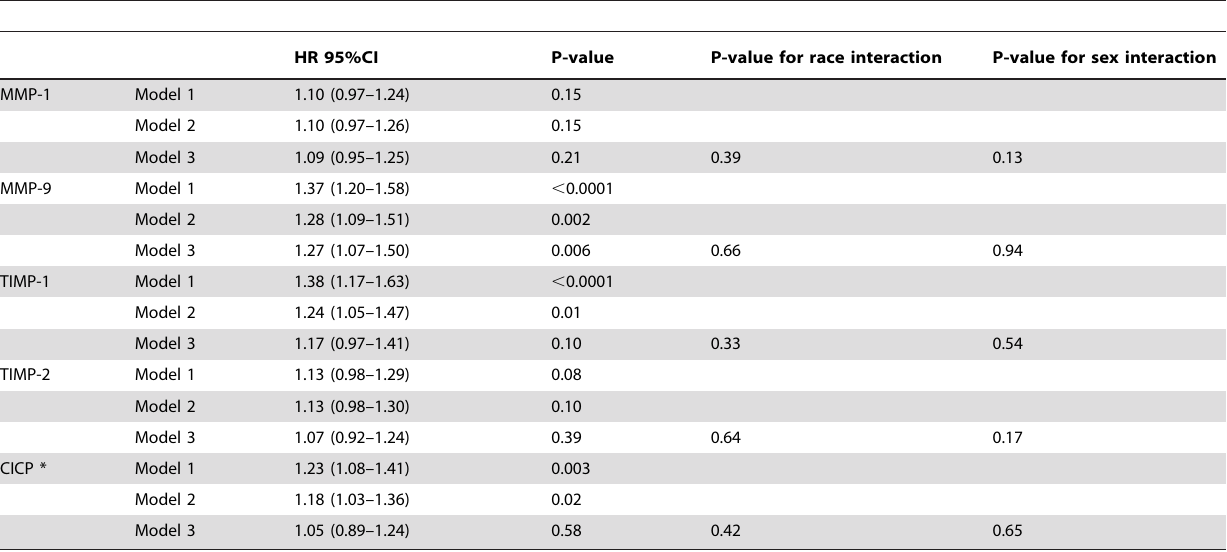
Table 2. Hazard ratio (95% confidence interval) of atrial fibrillation by markers of atrial ECM remodelling, ARIC, 1990–2007.